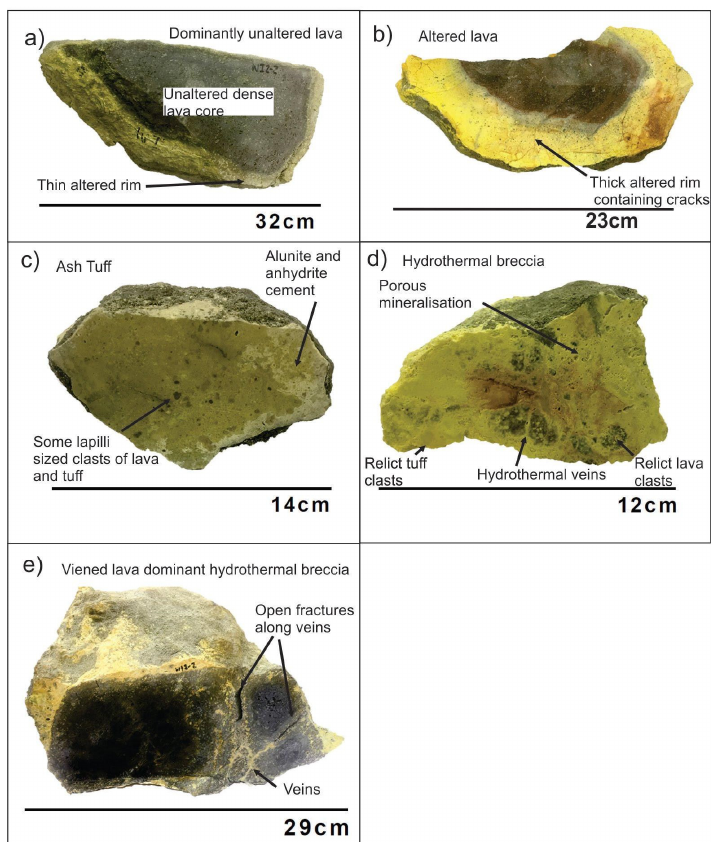
Figure 2. Photographs showing examples of collected ballistic samples from the 2016 eruption at Whakaari cut in two to reveal interior, ( a ) Unaltered lava, ( b ) altered lava, ( c ) Ash Tuff, ( d ) Hydrothermal breccia, ( e ) hydrothermal breccia of altered and unaltered lava.